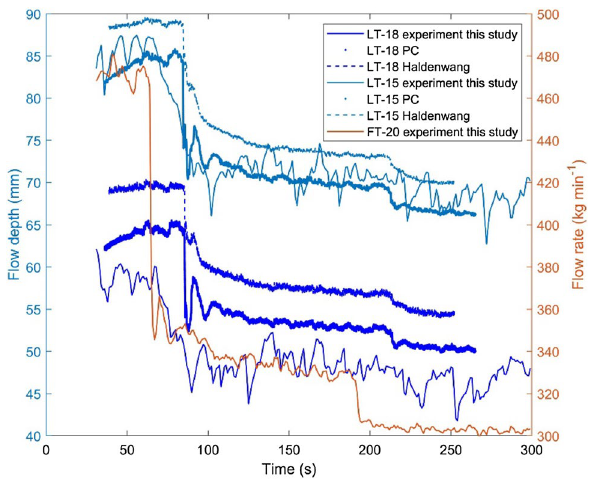
Fig. 8 Flow depth variation for drilling fluids, the rheology based x = 3.20 m on the Herschel–Bulkley model. The constant inlet flow rate is 0.0056 m 3 s −1 , and the channel angle is −